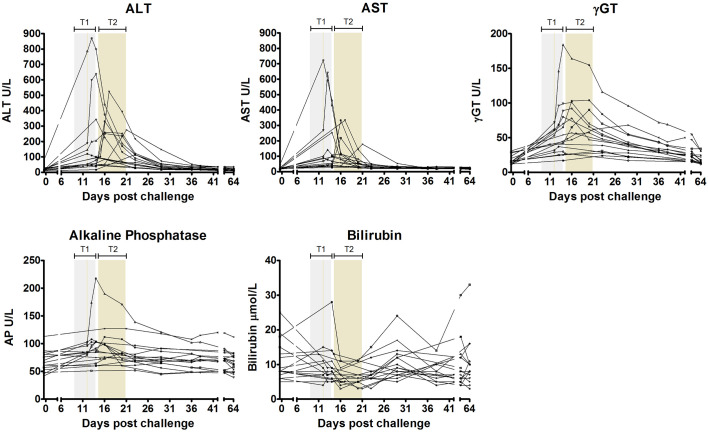
Liver function test derangements.ALT = alanine aminotransferase, AST = aspartate aminotransferase, γGT = gamma glutamyl transferase, ALP = alkaline phosphatase, T1 = Treatment 1, T2 = Treatment 2.